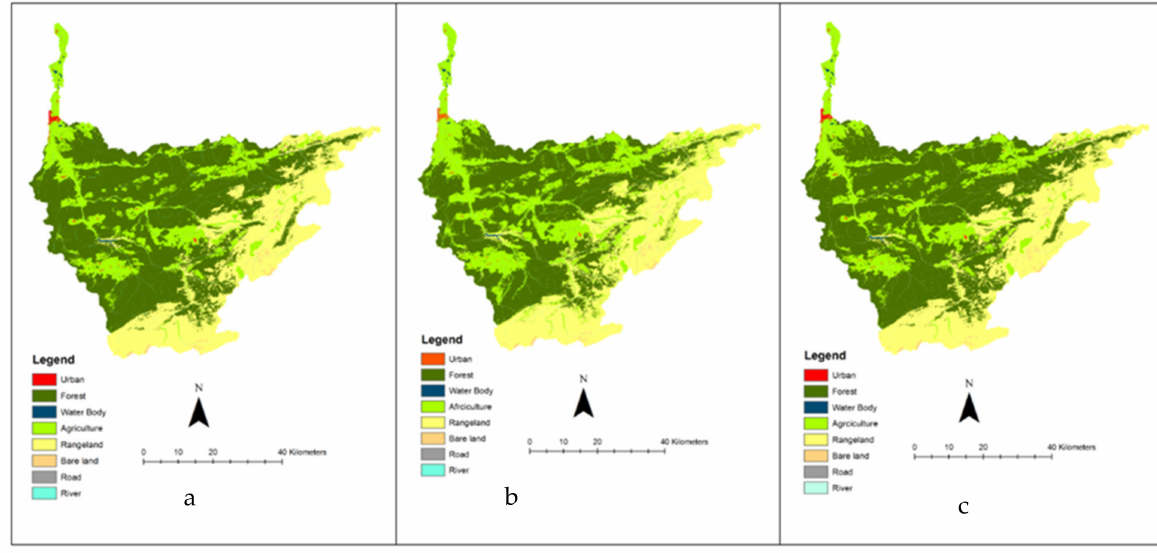
Figure 3. Land use maps for: ( a ) 2010, ( b ) Continuity scenario (2040) and ( c ) limitation and conservation scenario from left to